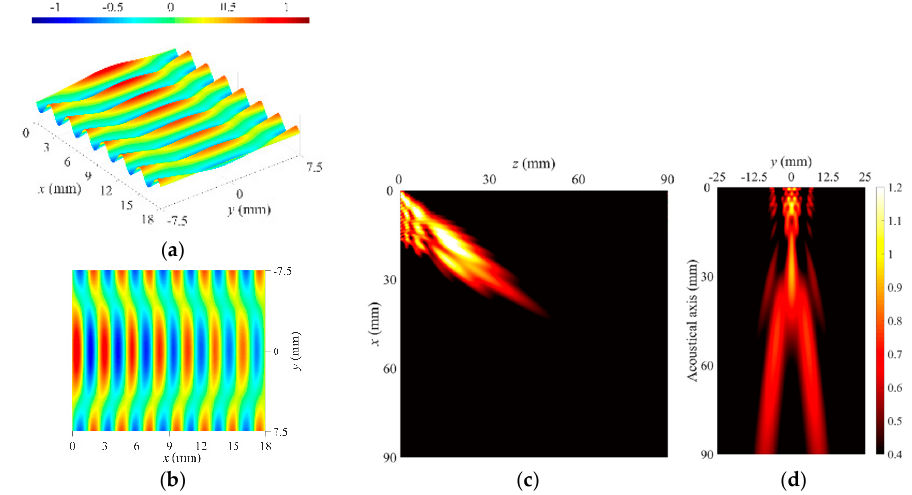
Figure 12. Simulation #1 of the leaky radiation beam profile based on the wave phase on the radiation surface. ( a ) Isotropic view of wave phase on radiation surface, ( b ) top view of wave phase on radiation surface, ( c ) vertical beam profile, and ( d ) lateral beam profile.